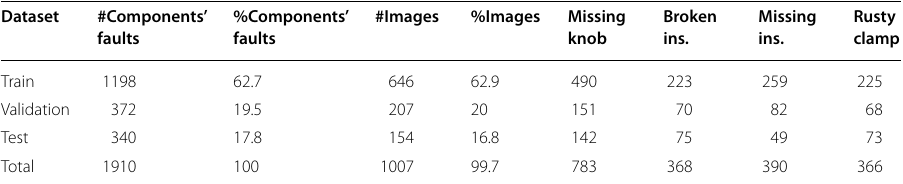
Table 3 Data partition